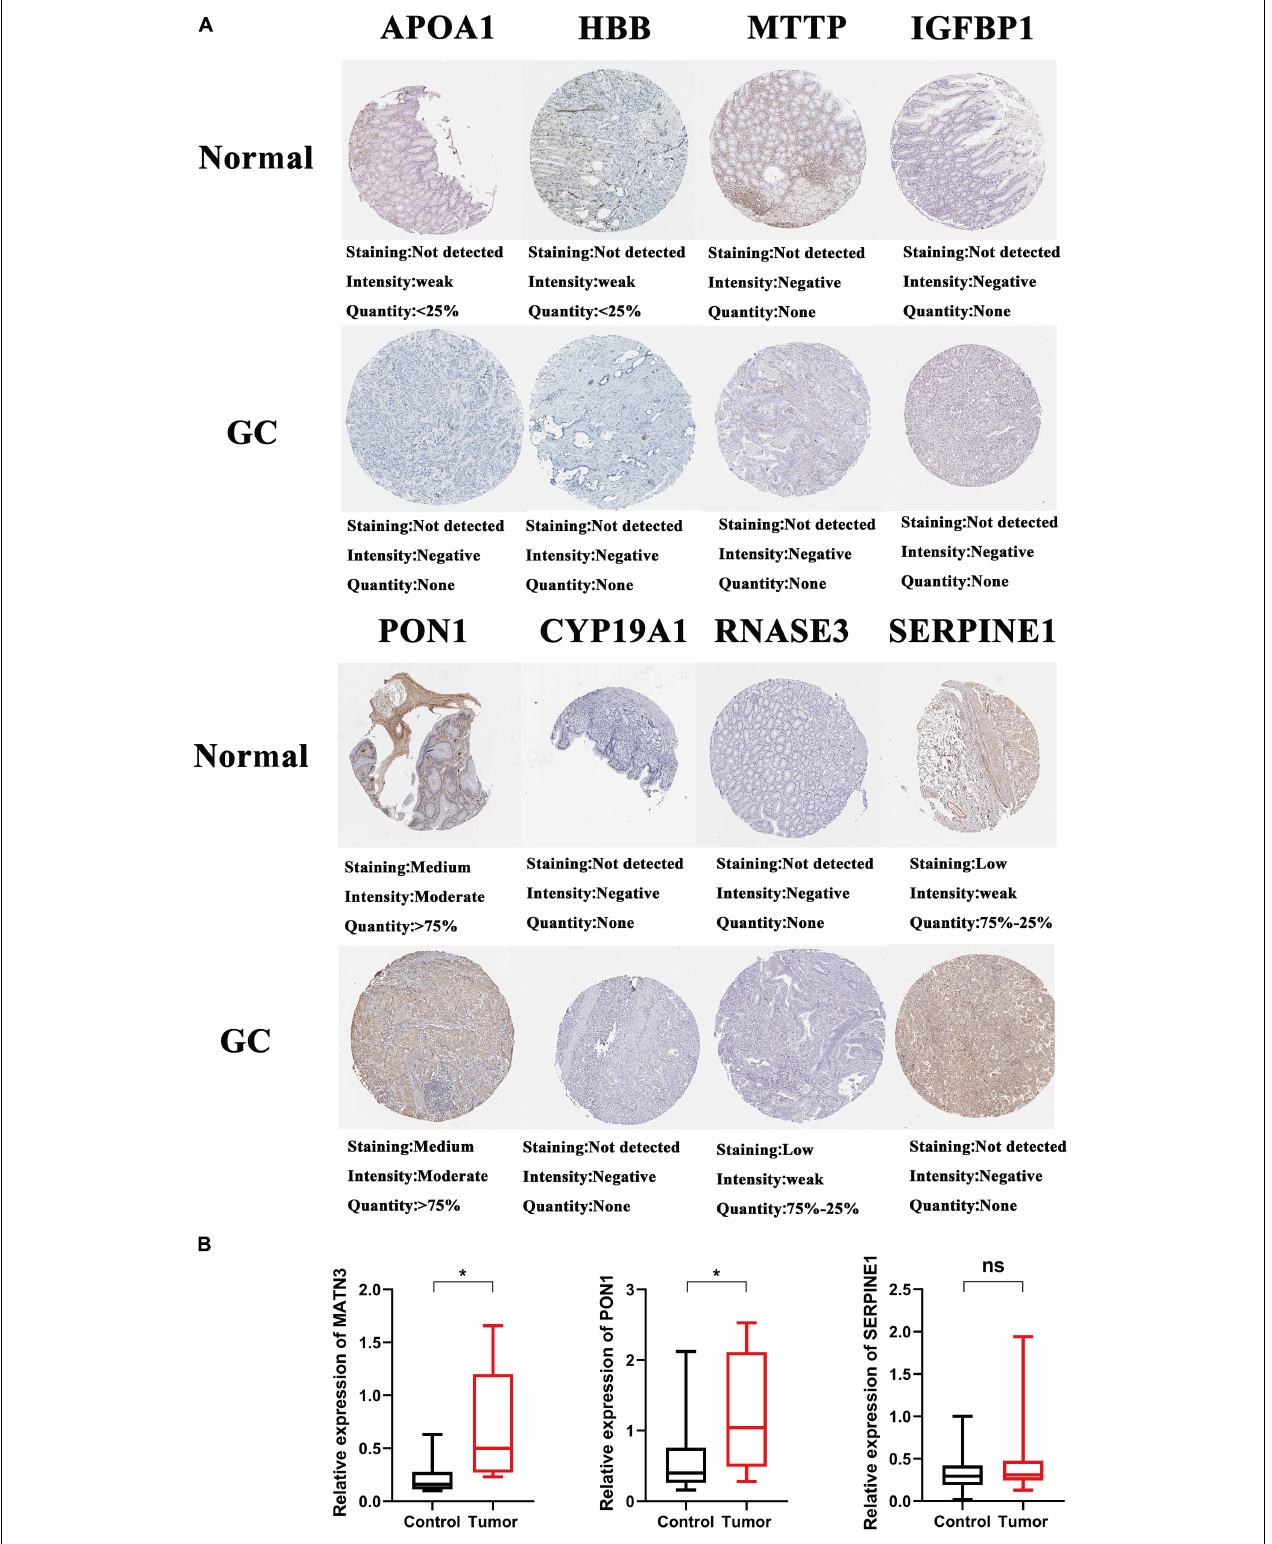
FIGURE 5 | The expression of candidate genes in GC and normal tissue. (A) The protein expression of the hub genes in the Human Protein Atlas (HPA) database. (B) the mRNA expression of PON1, MATN3, and SERPINE1 in GC and adjacent tissues, * p < 0.05.